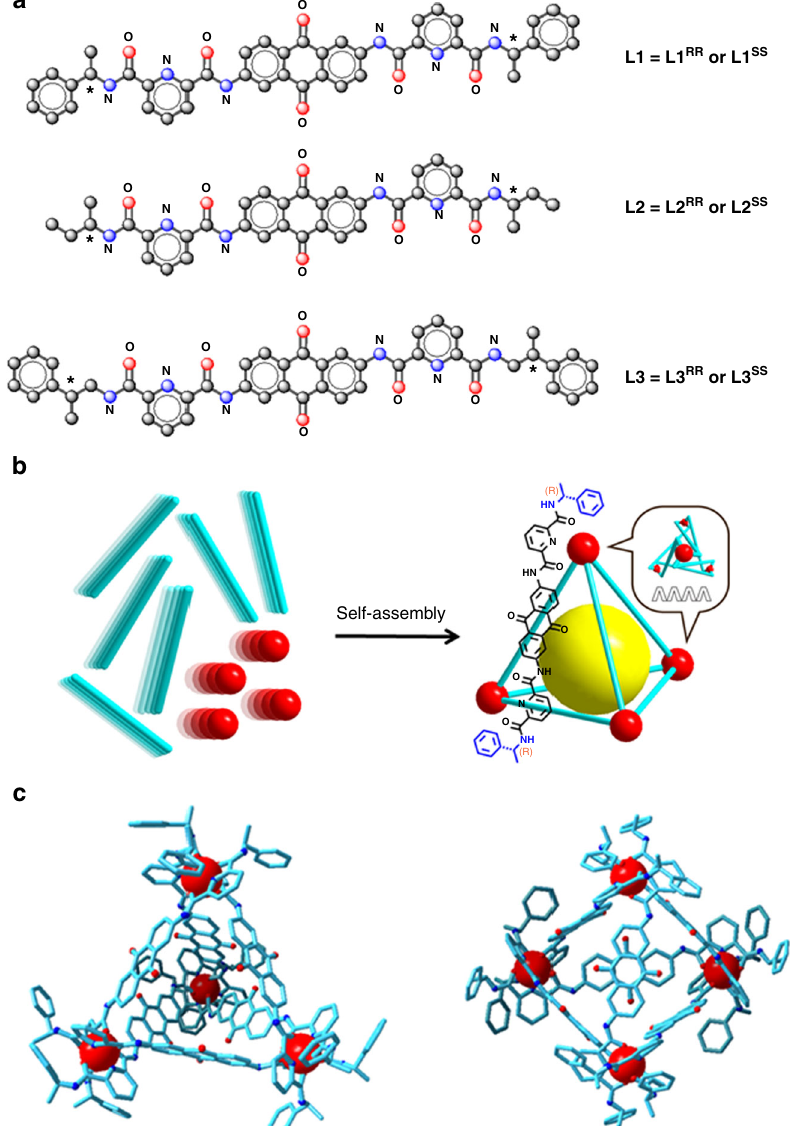
Fig. 1 Self-assembly of tetrahedral cages. a Ligands ( L = L1 – L3 ) used for studying the stereoselective formation behavior of the tetrahedral cages. b A projecture of the stereoselective formation of the tetrahedral cage Λ , Λ , Λ , Λ -[Eu 4 ( L1 RR ) 6 ](OTf) 12 ]. Cavity for potential encapsulation of guest molecules is highlighted as a yellow spherical space. c Energy-minimized schematic representation of the tetrahedral cage in two different